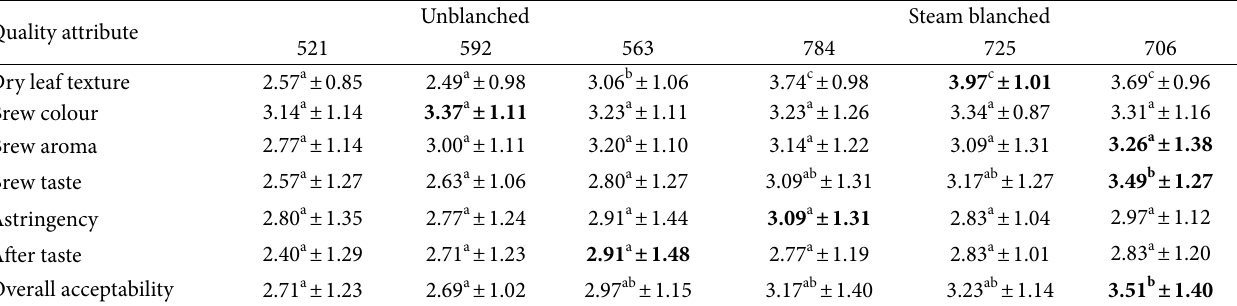
Table 5: Quality attributes of the sensory evaluation.